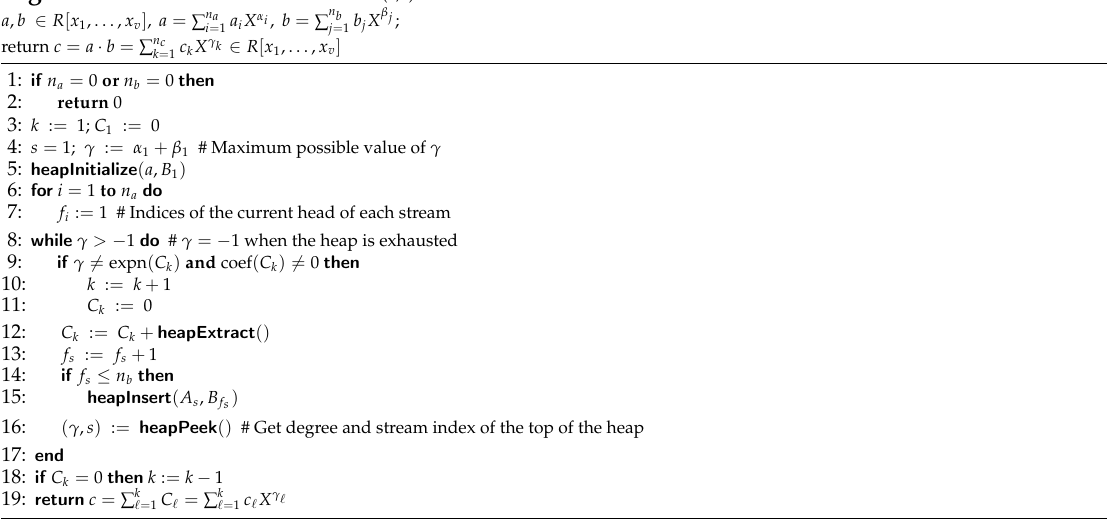
Algorithm 2 HEAP M ULTIPLY P OLYNOMIALS ( a , b